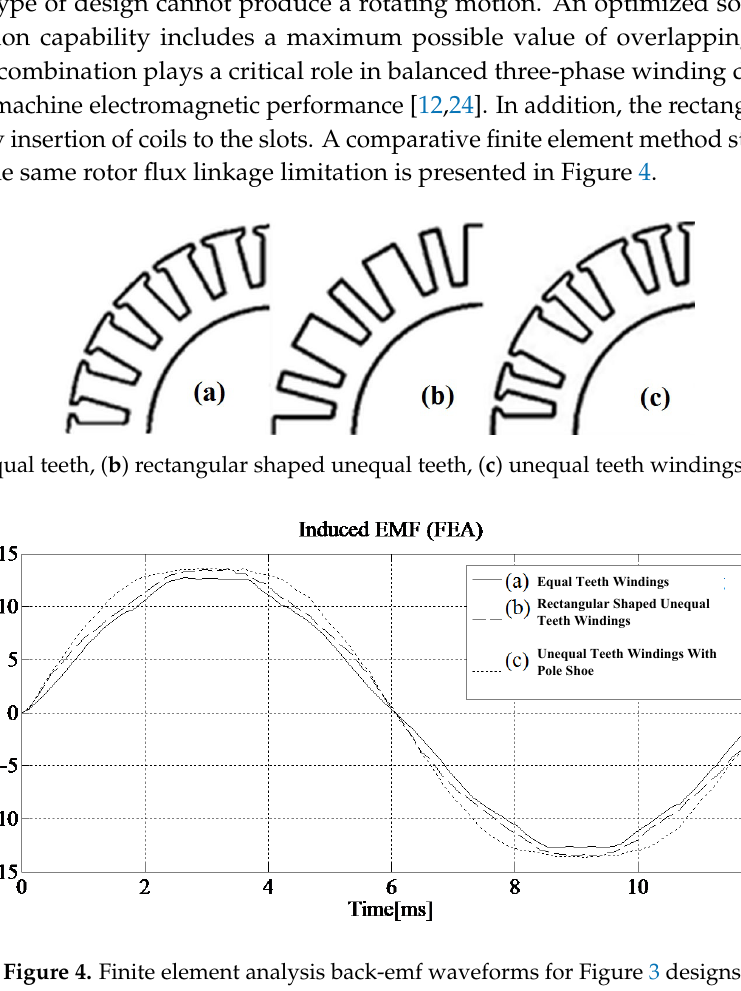
Figure 4. Finite element analysis back-emf waveforms for Figure 3